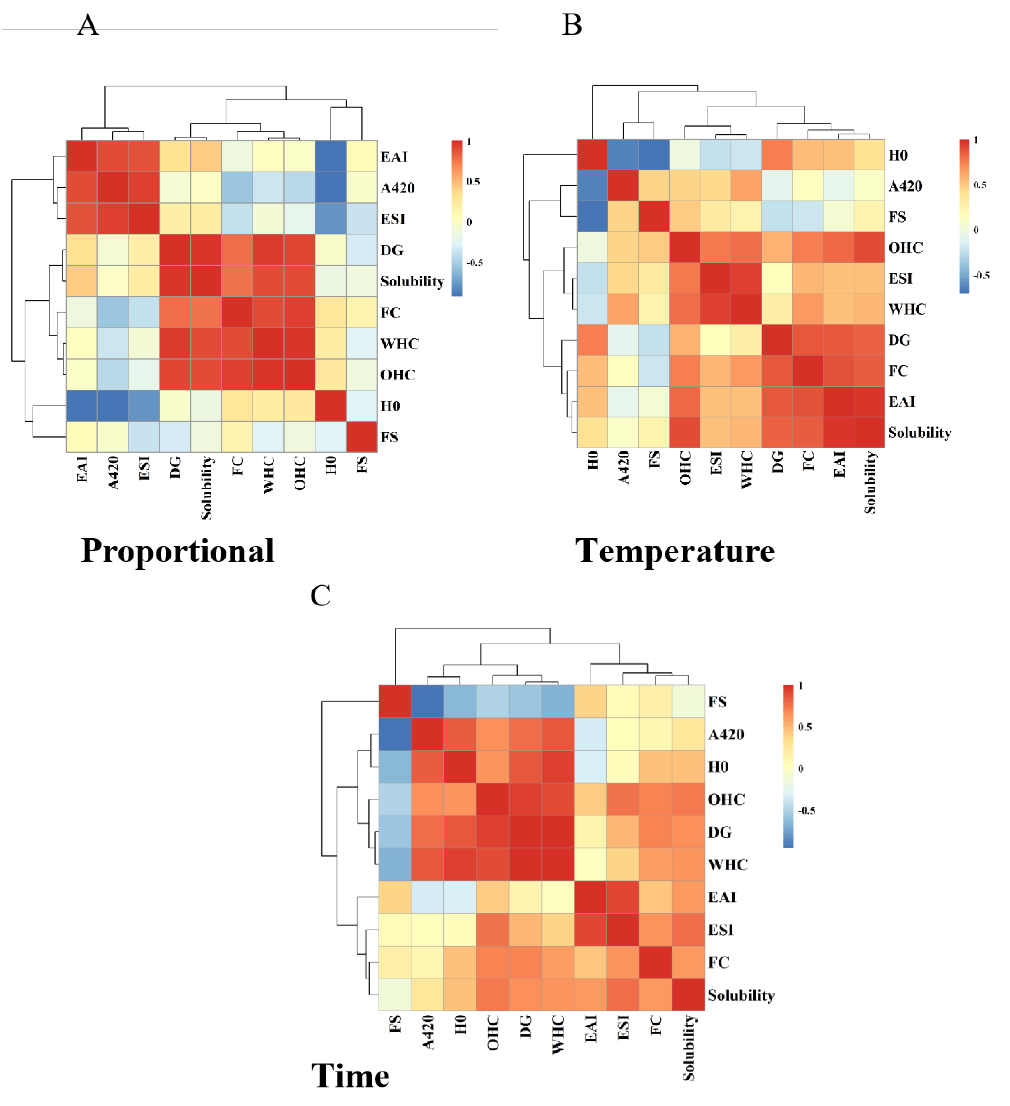
Figure 8. Correlation analysis between grafting (DG) and the functional properties of HPI–pullulan conjugate under different reaction conditions. ( A ): Analysis at different substrate ratios; ( B ): Analysis at different reaction tempetature; ( C ) Analysis at different reaction time.